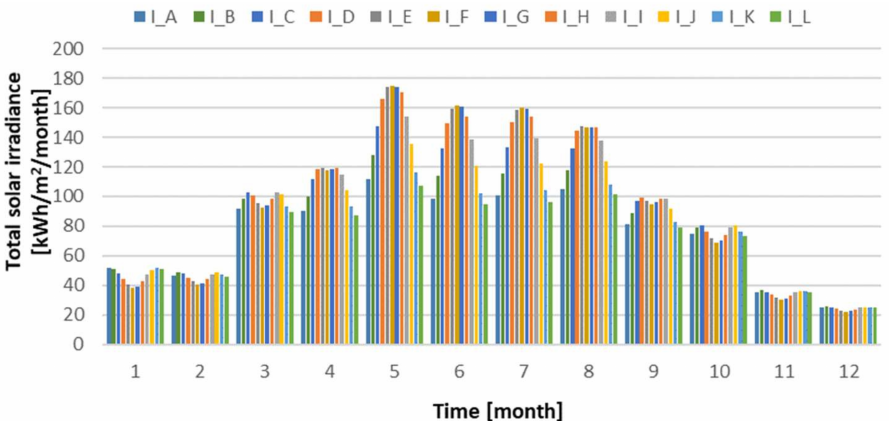
Figure 5. Total monthly solar irradiance incident on vertically positioned PV panels equipped with reflective surfaces.